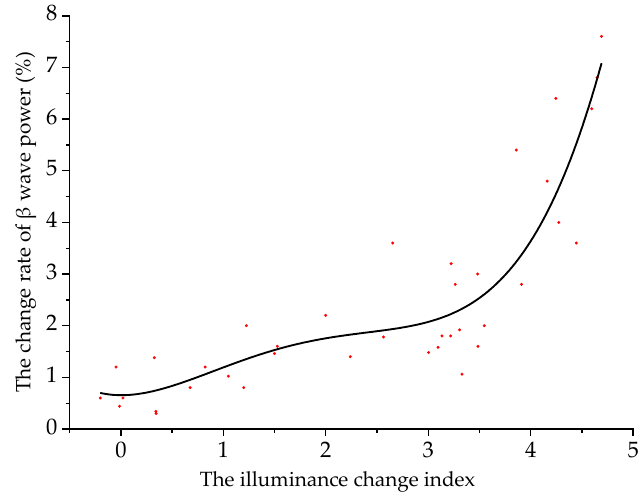
Figure 5. Fitting curve of illuminance change index and ∆ P β